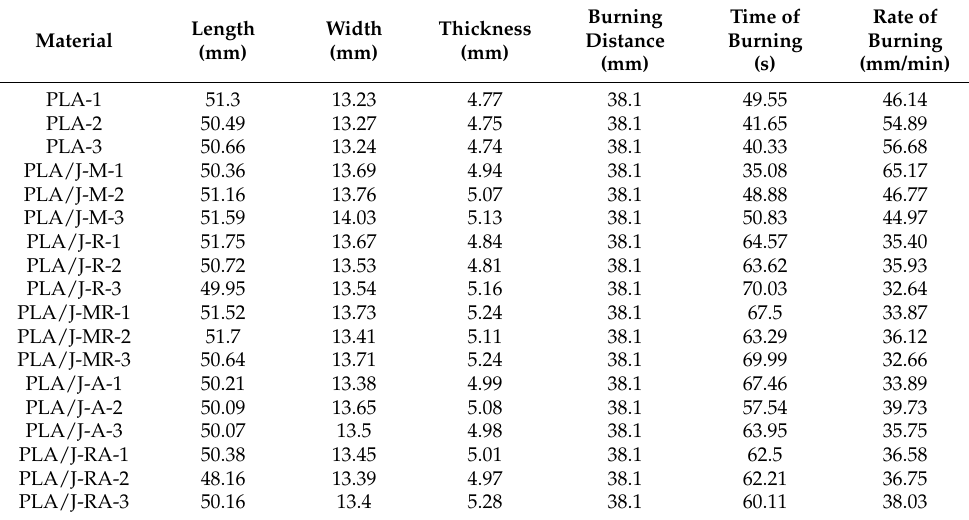
Table 3. Flammability test data report for PLA and PLA